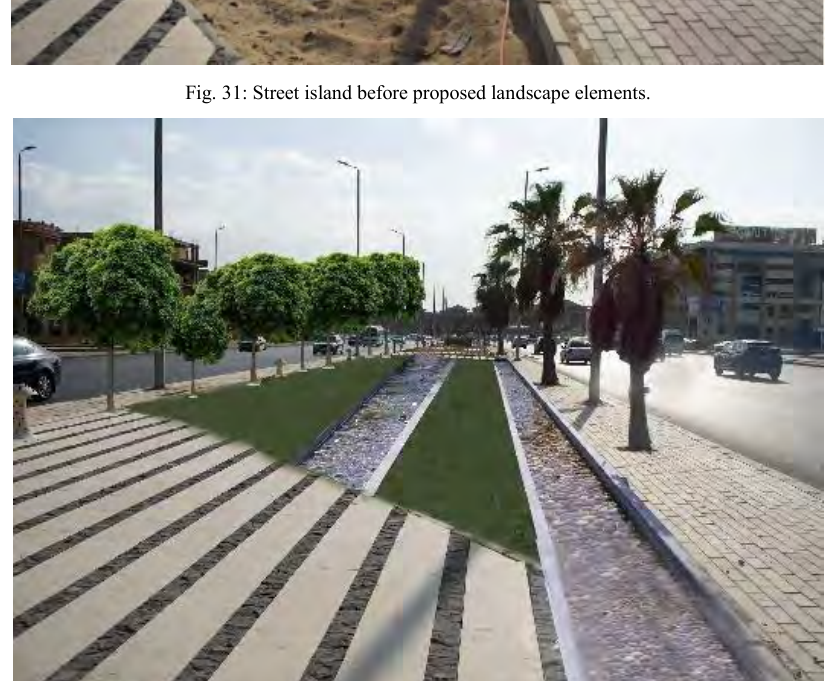
Fig. 32: Street island after